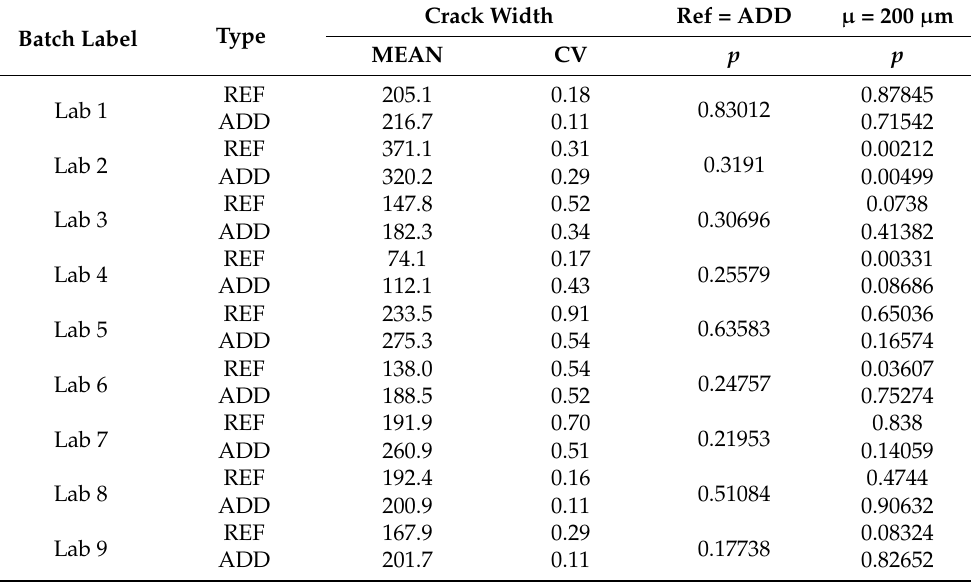
Table 8. Mean and coefficient of variation CV for the measured crack width of disc specimen, as well as the p -value for the statistical test comparing the mean to the target crack width of 200 µ m and the p -value for the test comparing the mean of the REF to the mean of the